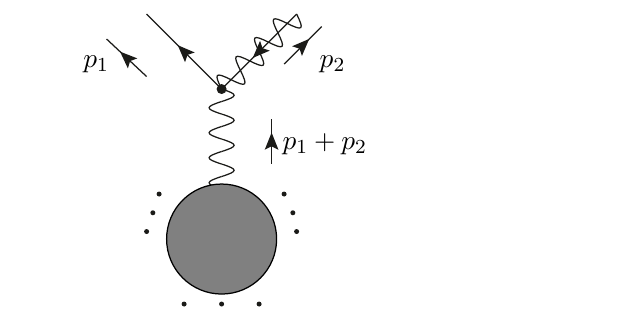
Figure 5 . The double wavy-solid line represents the gravitino decaying into a gauge boson and gaugino.